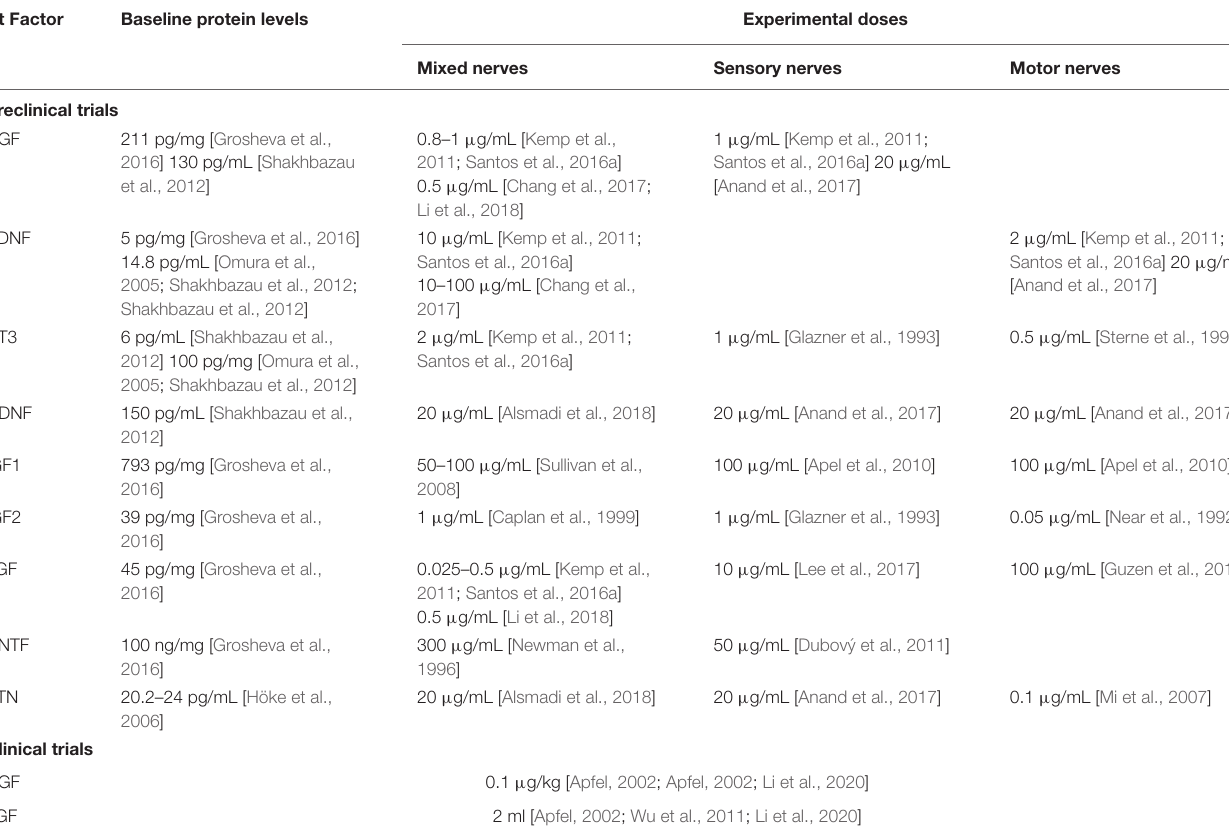
TABLE 3 | Baseline protein levels of the most important molecules involved in the regeneration process and doses employed to obtain a favorable regenerative environment. Nt Factor Baseline protein levels Experimental